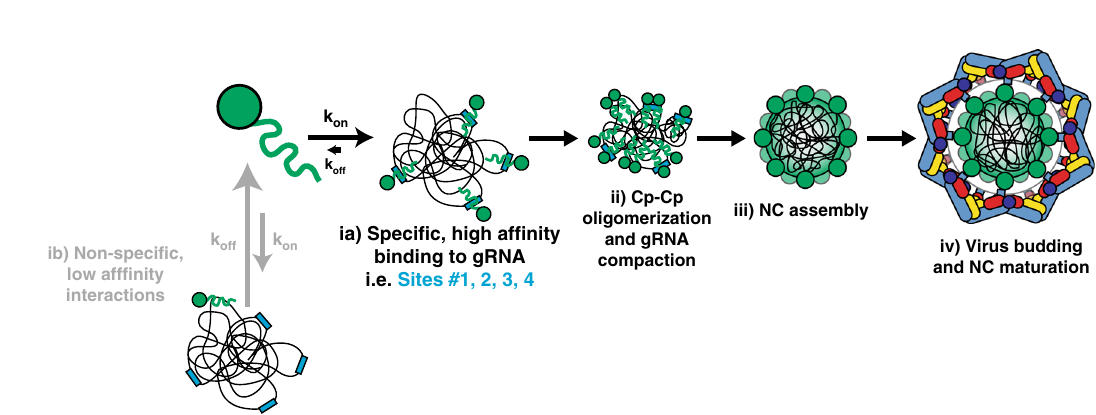
Fig. 6 Cp speci fi cally binds and assembles with site #1 in vitro. a Upper panel: 333 nM 32 P-labeled site #1 (left) or mutant (right; mutated residues highlighted in red) RNAs were bound to 13.3 pmole Cp immobilized on Streptactin beads in a 30- µ L reaction. Increasing concentrations (4 – 1000 nM) of random RNA were added as a competitor. Bound RNAs were extracted and subjected to Urea-PAGE followed by autoradiography. Lower panel: as above, but immobilized Cp was fi rst preincubated with 20 μ g/mL of poly(I:C) to shield non-speci fi c electrostatic interactions. Results are representative of two independent experiments. b Negative stain EM of CLP assembly reactions of Cp + 10mer or Cp + 10mer + Site #1 RNA. Dashed boxes in the right panel are ×3 magni fi cation of the corresponding left panel. Scale bar is 80 nm. Images represent one experiment. c CLP assembly reactions were incubated for 30 min at 25 °C (150 mM NaCl) and then analyzed by sucrose gradient sedimentation. Cp from aliquots of fractions was detected by ELISA. Individual data points from technical duplicates are plotted and the line represents their mean. Fraction 1 is the top of the gradient. Results are representative of n = 4 independent experiments for Cp alone, Cp + 10mer (1:20), Cp + Site #1 (1:1), and Cp + 10mer + Site #1 (1:20:1), and n = 2 independent experiments for Buffer alone. d As in c , except the indicated salt concentrations were used in CLP assembly reactions comparing CLP assembly with site #1 or mutant RNAs. Individual data points from technical duplicates are plotted and the line represents their mean. Results are representative of n = 4 independent experiments for 250 mM NaCl, and n = 2 independent experiments for 150, 300, and 350 mM NaCl. See also Supplementary Fig. 5.